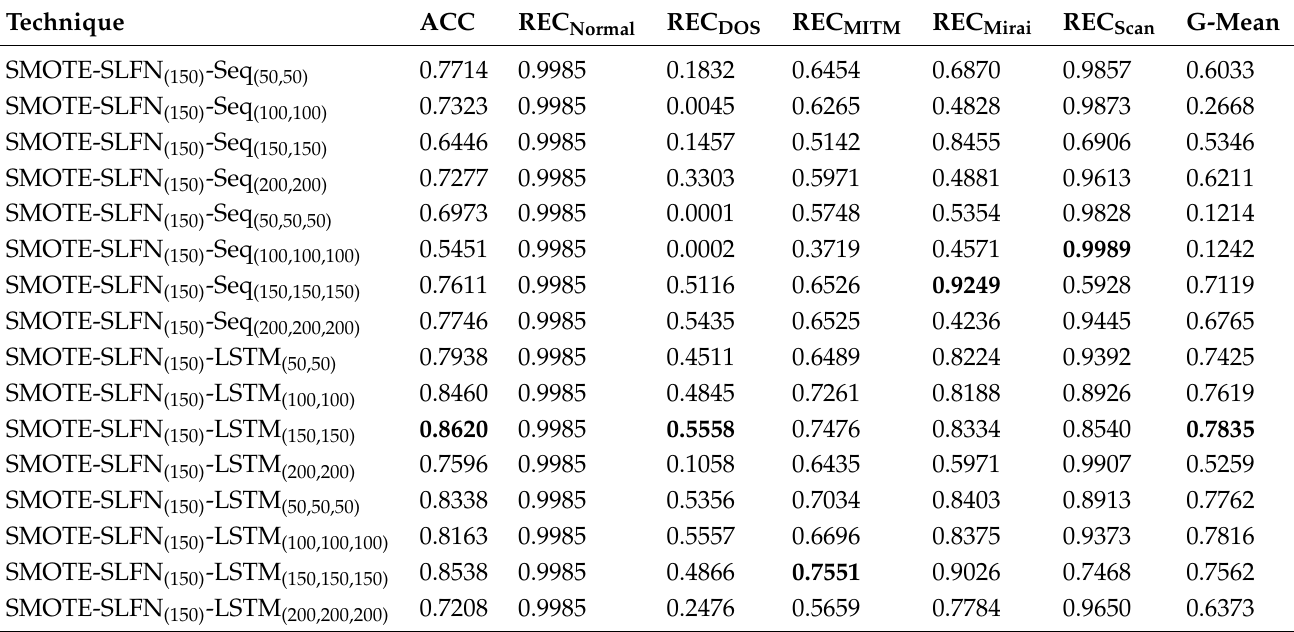
Table 5. Intrusion type detection using a deep learning sequential model and LSTM with a different number of layers and neurons. Bold font indicates best